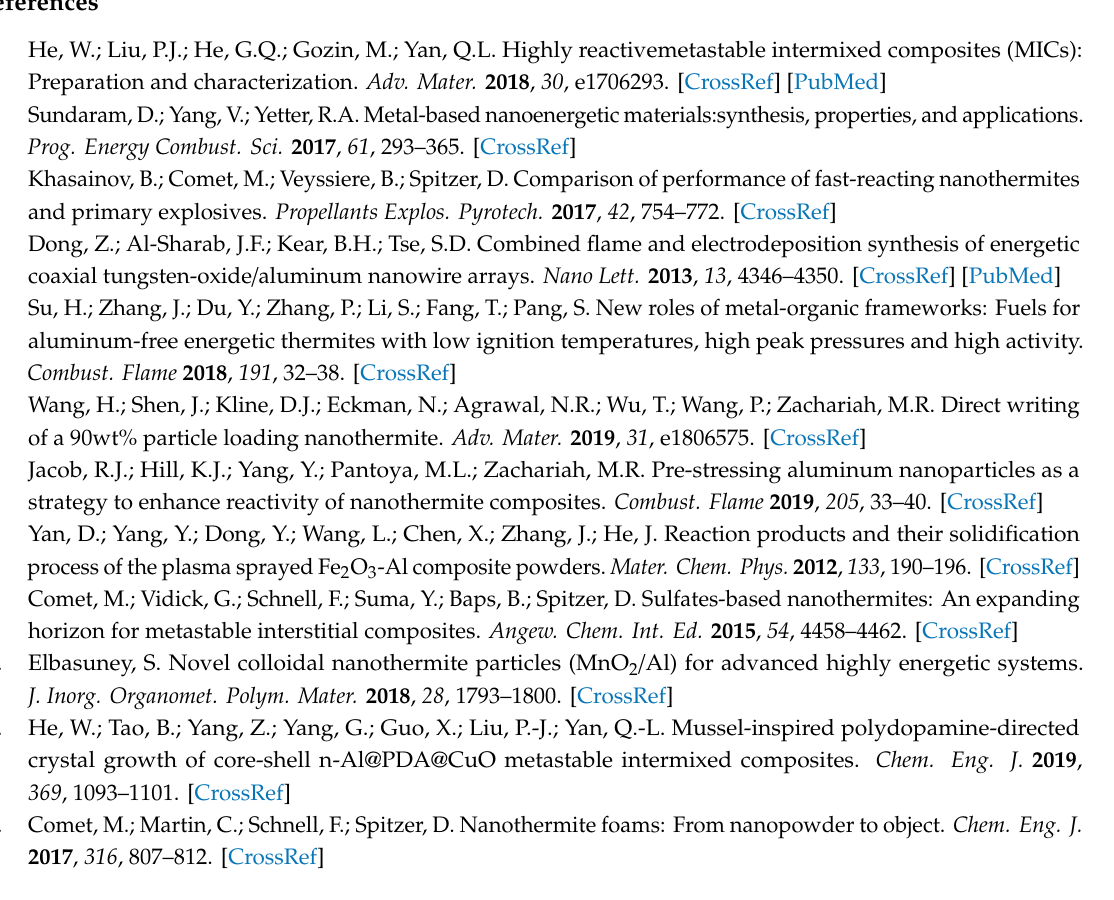
Figure S1: The SEM images of the MnCo 2 O 4 NWs film, Figure S2: The SEM images of the MnCo 2 O 4 / Al NWs nanothermite film. (Al = 200 nm), Figure S3: The XRD pattern of the (a) MnCo 2 O 4 NWs film and (b) MnCo 2 O 4 / Al NWs nanothermite film, Figure S4: The SEM images of the NiCo 2 O 4 NWs film, Figure S5: The XRD pattern of the NiCo 2 O 4 NWs film, Figure S6: The SEM images of the NiCo 2 O 4 / Al NWs nanothermite film. (Al = 200 nm), Figure S7: The DSC curve of CoFe 2 O 4 / Al NWs nanothermite film with di ff erent Al deposition thicknesses (a) 200 nm and (b) 600